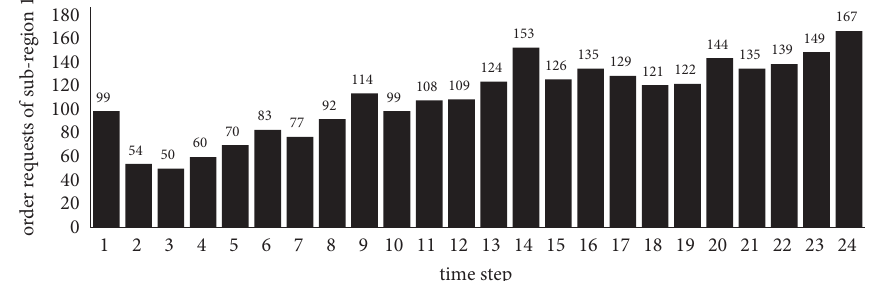
Figure 10: Order requests initialization configuration of 1–7 subregions from 8: 00 a.m.–2:00 p.m.